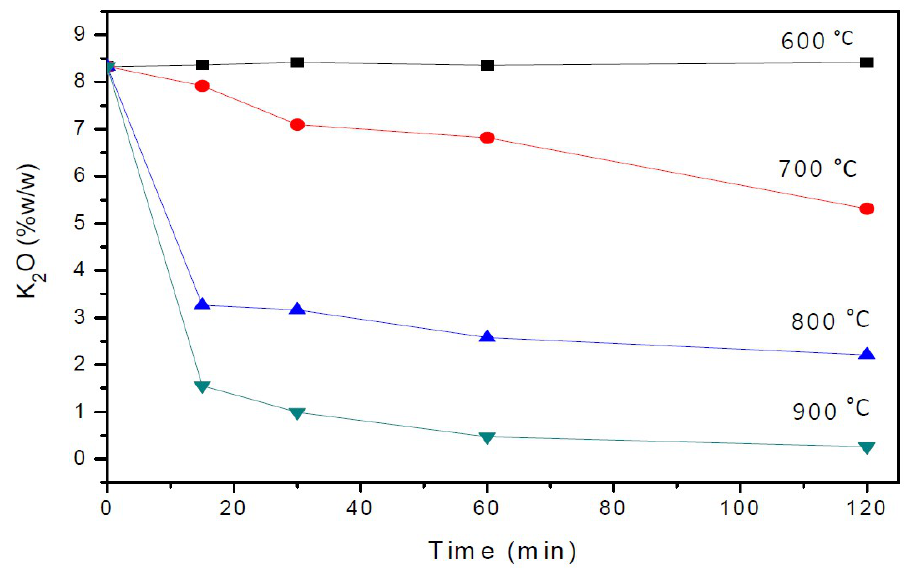
Figure 6. Content of K 2 O in residues of the M1 sample calcined in Cl 2 (g) at different temperatures and reaction times.